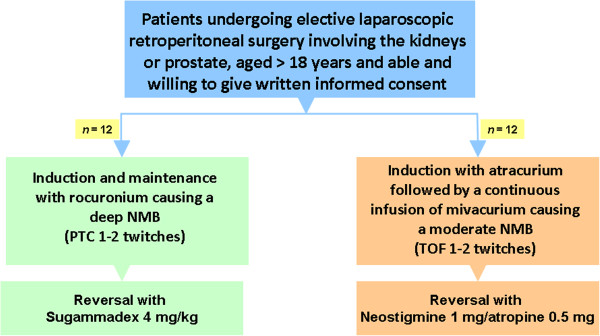
Study flow chart.